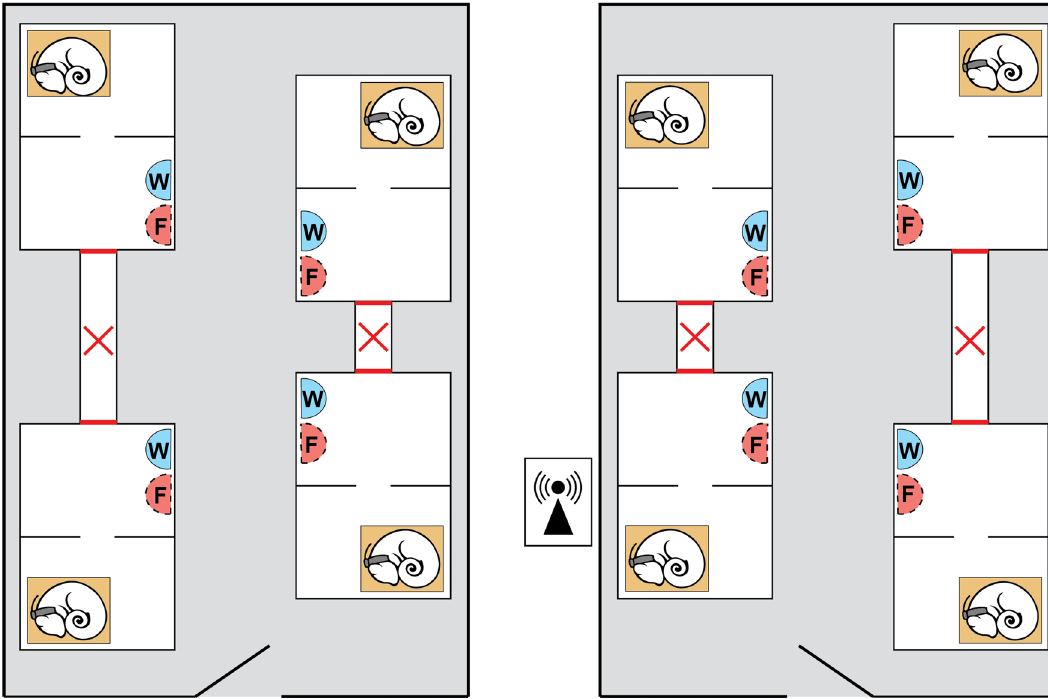
Figure 6. Schematics of the experimental setting. Grey boxes represent the rooms; white boxes represent the individual lemurs’ enclosures; brown boxes represent the wooden nest/”hibernacula”; F and W reflect the placement of food and water dishes, respectively.